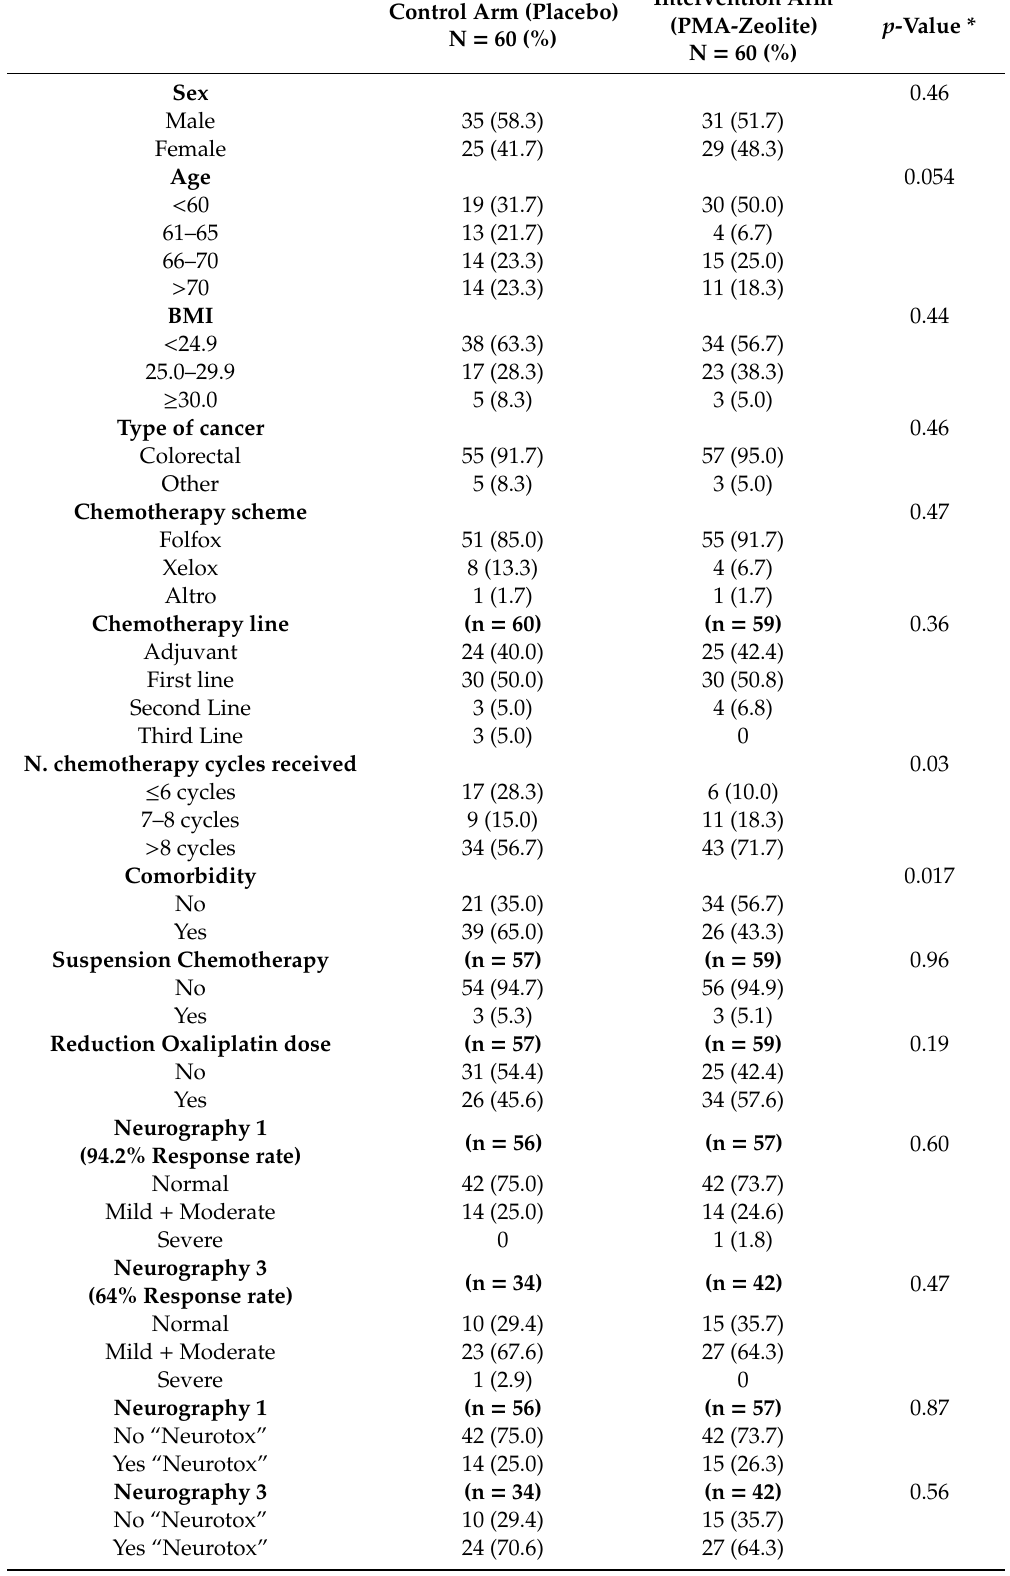
Table 2. Distribution of demographic and clinical